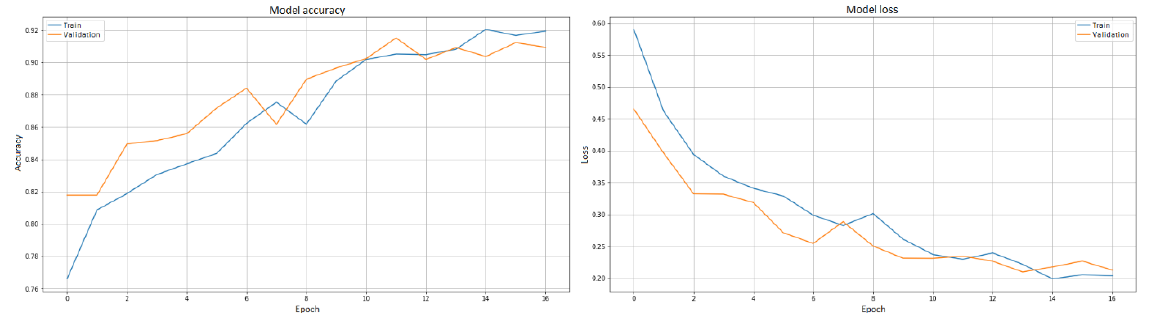
Figure 12. Zrenjanin—accuracy and loss function curve.